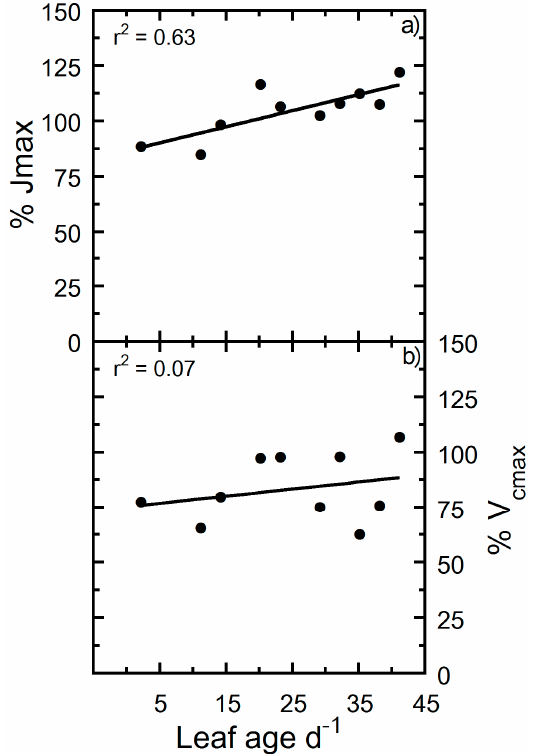
Figure 5. Percent change of photosynthetic physiology to photon flux of 1500 versus 500 µ mol m − 2 s − 1 . ( a ) Percent change of 500 relative to 1500 µ mol m − 2 s − 1 maximum electron transport rate (J max ) and ( b ) percent change of 500 relative to 1500 µ mol m − 2 s − 1 maximum Rubisco carboxylation rate (V cmax ). Solid lines are linear regressions fitted to the entire data set.